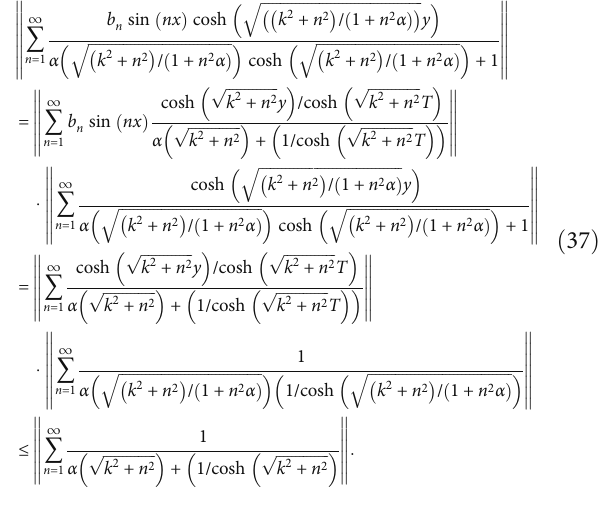
p  ffiffiffiffiffiffiffiffiffiffiffiffiffiffi ffiffiffiffiffiffiffiffiffiffiffiffiffiffi k 2 + n 2